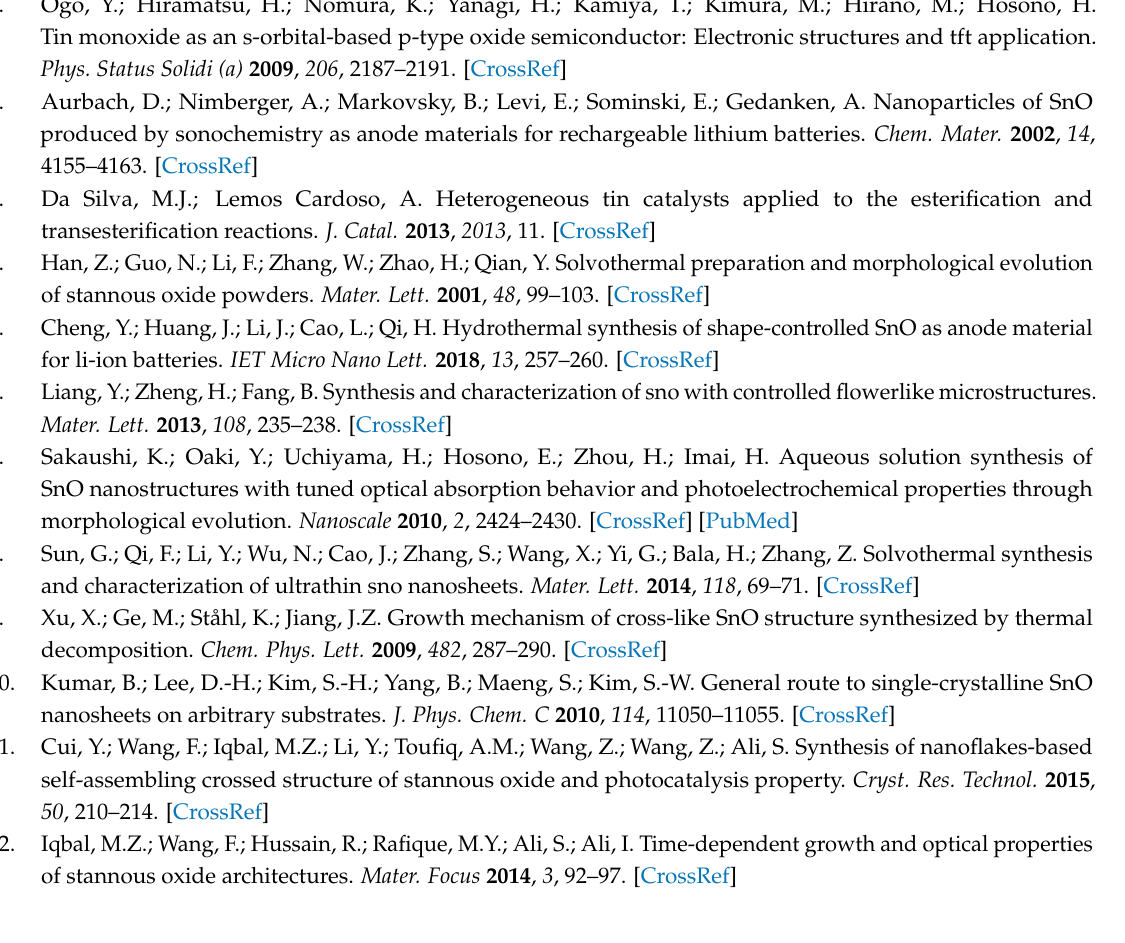
Figure S1: Schematic description of the phage display technique. Figure S2: Structural characterization of the commercial SnO powder. Figure S3: Overview SEM images of the reference particles synthesized without peptides. Figure S4: Schematic description of the construction of three solid-state synthesized peptides, based on the sequence of SnBP01 for the mineralization study of tin(II) oxide microstructures. Figure S5: Overview SEM images of the SnO particles synthesized with of 1 nM peptide SnBP01-2 (WKLK). Figure S6: Overview SEM images of the SnO particles synthesized with of 1 nM peptide SnBP01-1 (LPPW). Figure S7: Overview SEM images of the SnO particles synthesized with of 1 nM peptide SnBP01